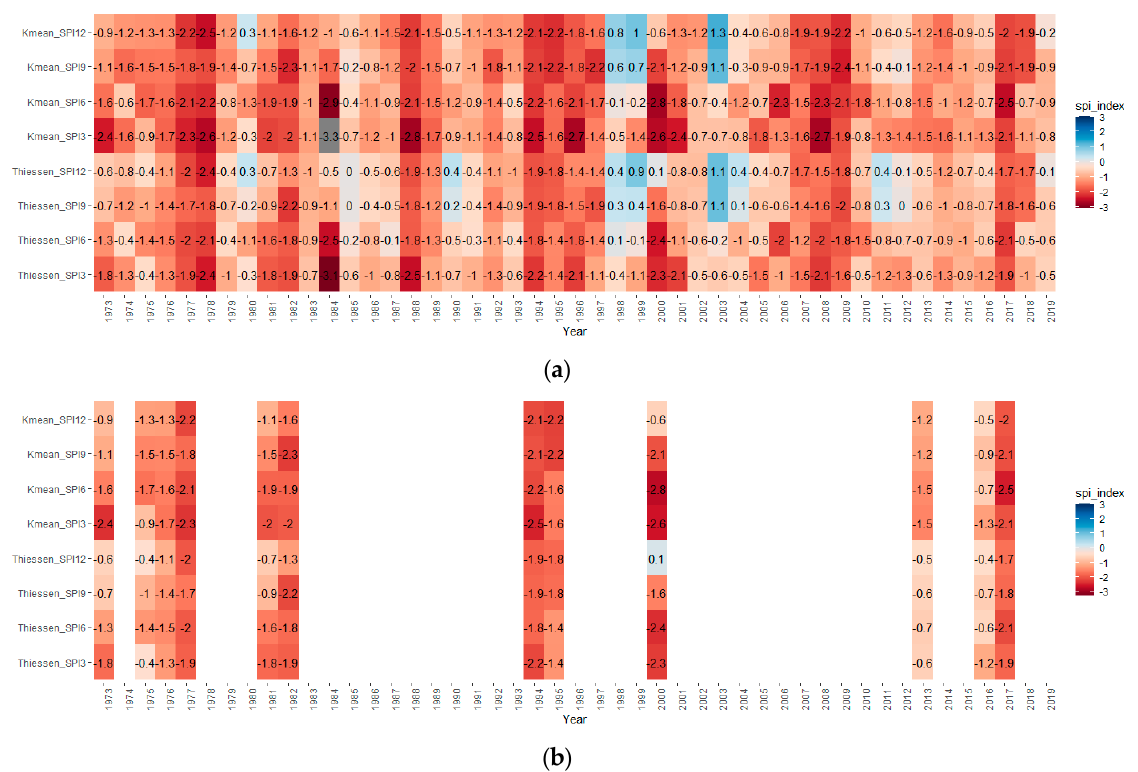
Figure 10. SPI of Gyeongsangnamdo by duration based on k-means cluster analysis: ( a ) SPI3; ( b ) SPI6; ( c ) SPI9; ( d ) SPI12.